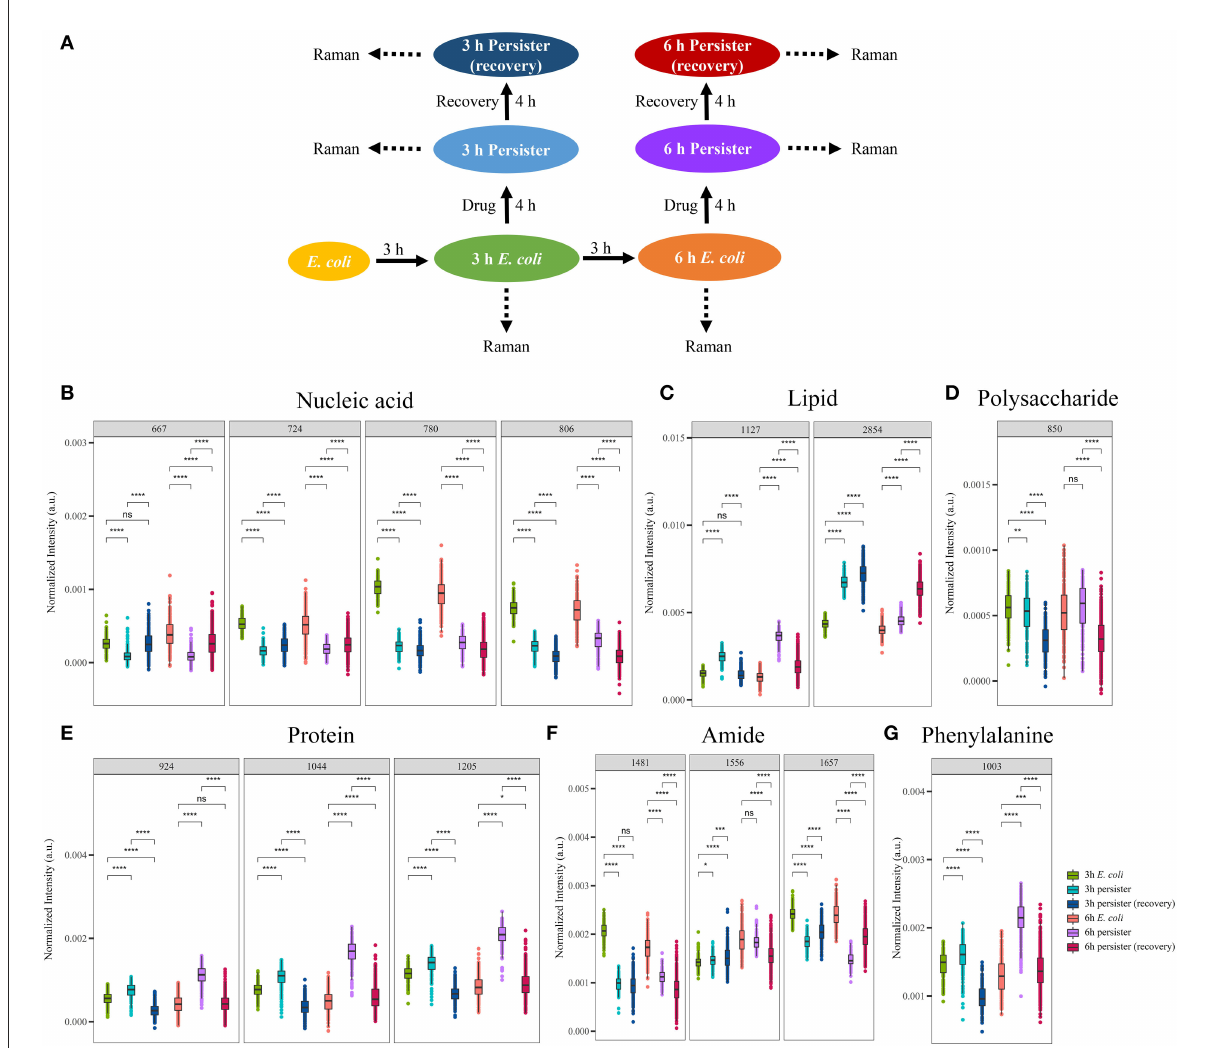
FIGURE6 Single-cell Raman spectra of E. coli persisters before/after ampicillin treatment and after resuscitation. Overnight planktonic-cultured E. coli (12h) was 1:100 diluted into fresh LB broth and further cultured for 3 and 6h, followed by ampicillin treatment (100 µ g/mL, 32 × MIC) for 4h. Then, the persisters were washed two times with Milli-Q water and further cultured in fresh LB broth without the drug for another 4h. Single-cell Raman spectra were acquired at different time points. (A) Workflow of Raman spectra detection. (B–G) Intensity of Raman bands